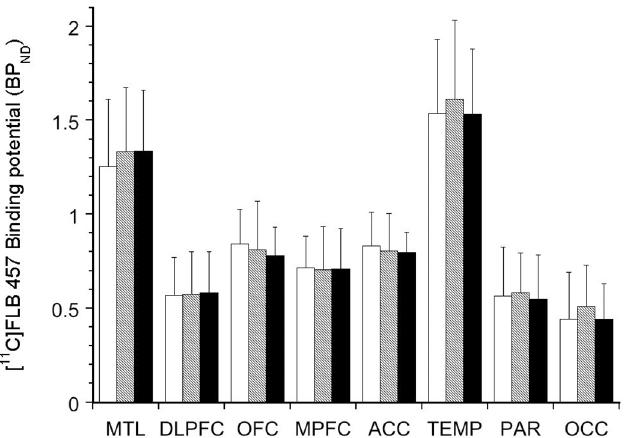
Fig 1. Baseline [ 11 C]FLB 457 Binding Potential (BP ND ) in Genotyped Healthy Subjects. The bar graph shows the lack of difference in D 2/3 receptor availability in cortical regions of interest comparing Val/Val (white bars), Val/Met (shaded bars), and Met/Met (black bars) genotyped healthy subjects.